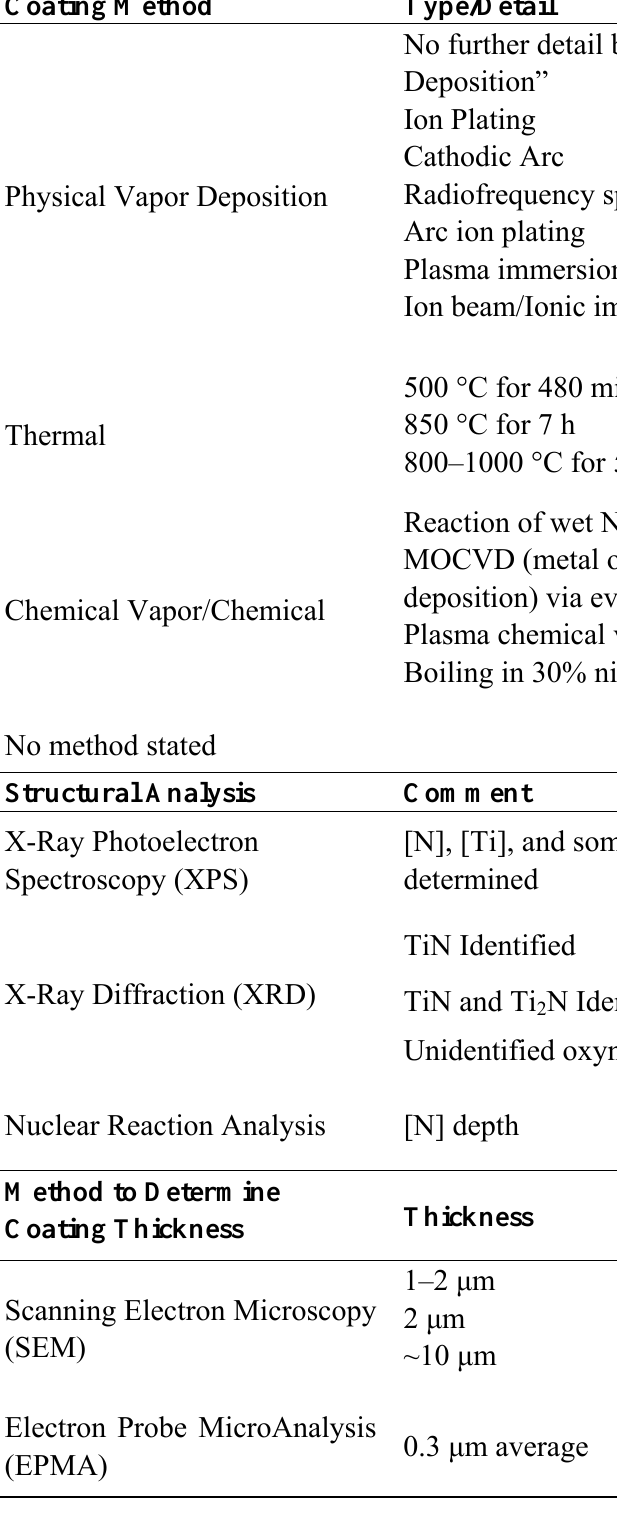
Table 1. Compilation of coating methods, structural (composition and phase) analysis methodology, and coating thickness listed in the various dental materials